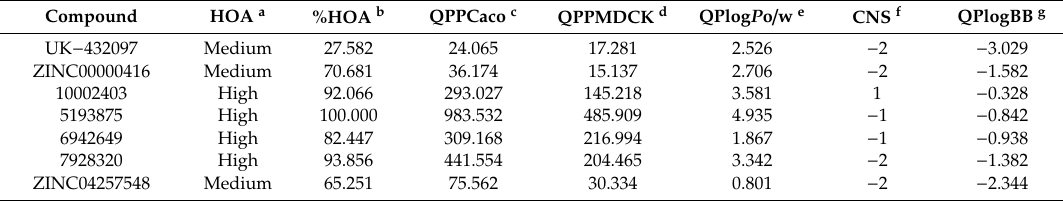
Table 7. Molecular properties calculated for evaluation of metabolism and pharmacokinetic profiles of UK-432097 and compounds selected by virtual screening